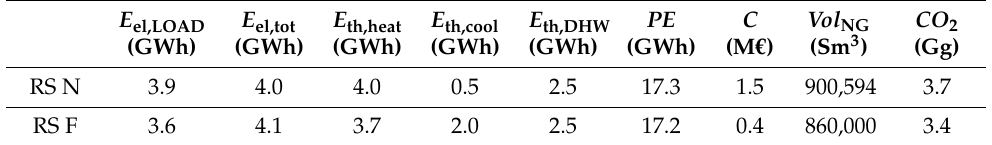
Table 9. Estimated annual performance (energy, economical and environmental) of the reference system in the districts located in Naples (RS N) and Fayoum (RS